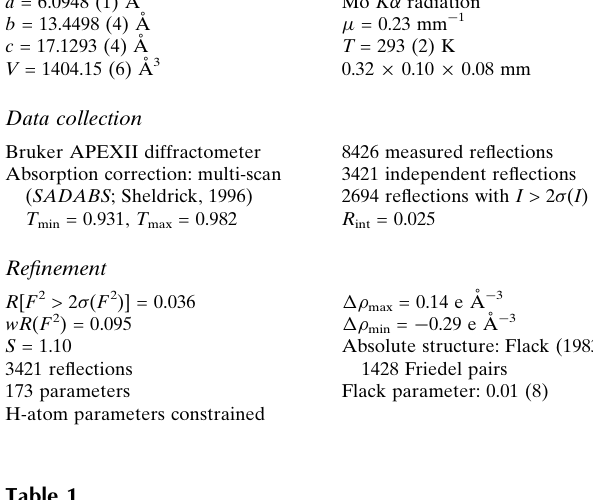
Bruker APEXII diffractometer Absorption correction: multi-scan